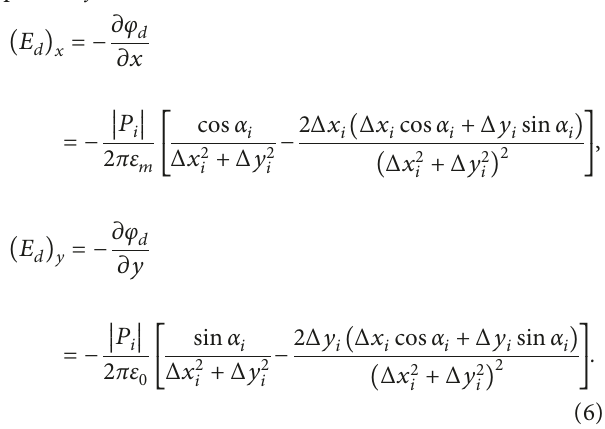
/2 in a uniform DC electric field with E 1kV/m 0 (cid:31) (cid:31) π